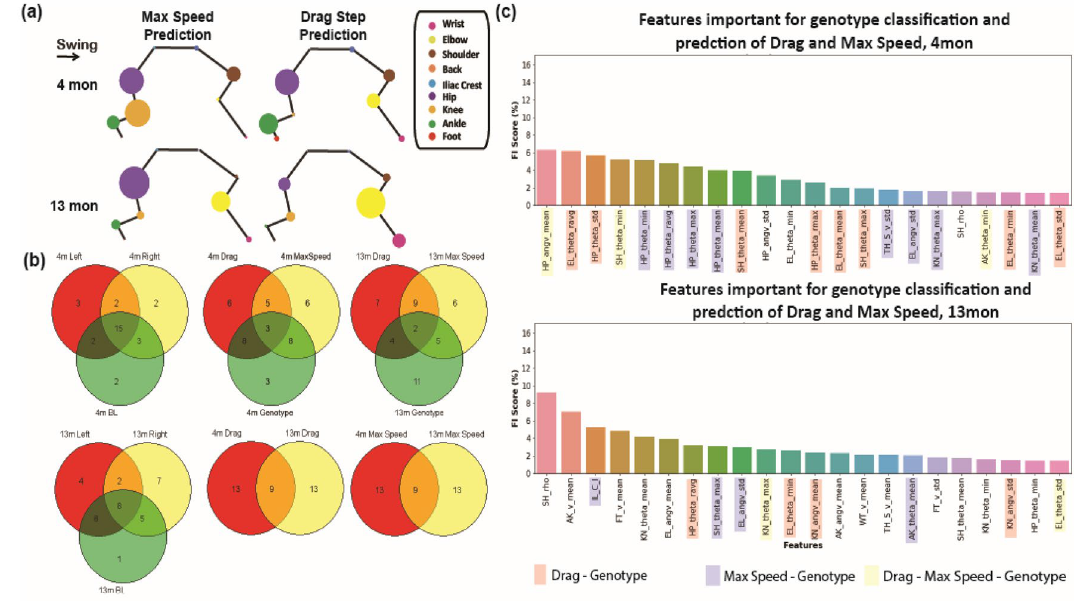
Figure 6. Features important for the prediction of drag steps or the maximum speed. Selected by the support vector regressor (SVR) based regression model. We investigated whether the kinematic features of treadmill stepping at 6 m/min could predict the maximum treadmill speed that the animal could run or the number of drag steps out of 10 consecutive steps. ( a ) The cumulative feature importance score (FI%) of the top 22 features for each joint for predicting the maximum speed and number of drag steps were presented for 4mon and 13mon, respectively. ( b ) The different and the common features among the 22 most important features predicting the number of drag steps or maximum speed based on SVR model, and genotype classification selected based on random forest. ( c ) The overlapping among the subsets of features optimized for genotype classification and the other two feature subsets optimized for drag step or maximum speed prediction for 4mon and 13mon. Red represents the features shared between the feature subsets optimized for drag step prediction and the genotyping classification; Blue represents the features shared between the feature subsets optimized for maximum speed prediction and the genotyping classification; Yellow represents the features shared among all three feature subsets. Panels generated through Python 3.7, MATLAB 9.2, and Adobe Illustrator